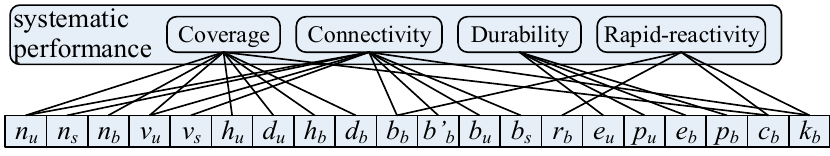
Figure 5. Map relationship between performances and parameters.